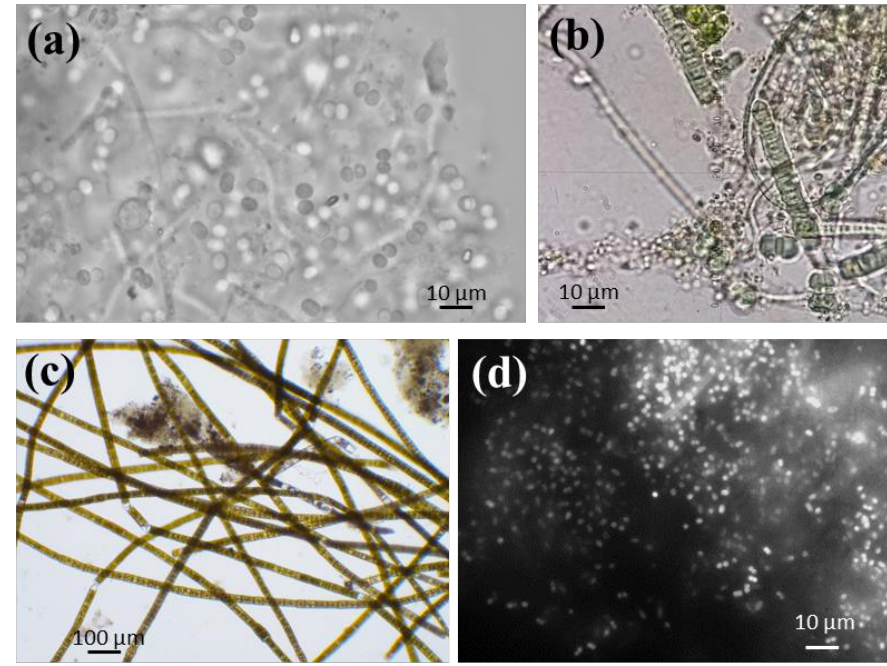
Figure 4. Microscopic images of the mixed liquor of the photobioreactors: ( a ) Coccal Cyanobacteria resembling Synechococcus sp. and small filamentous Cyanobacteria, surrounded by green microalgae, ( b ) filamentous Cyanobacteria resembling to Oscillatoria sp. and Leptolyngbya sp. and coccoid Cyanobacteria resembling to Chroococcus sp., Synechococcus sp. and Synechocystis sp., and ( c ) filamentous green microalgae, observed under bright light microscopy during the operation of the photobioreactors in parallel; and ( d ) higher dominance of Synechococcus sp. with some presence of Pseudanabaena sp., observed under fluorescence microscopy during the operation of the photobioreactors in